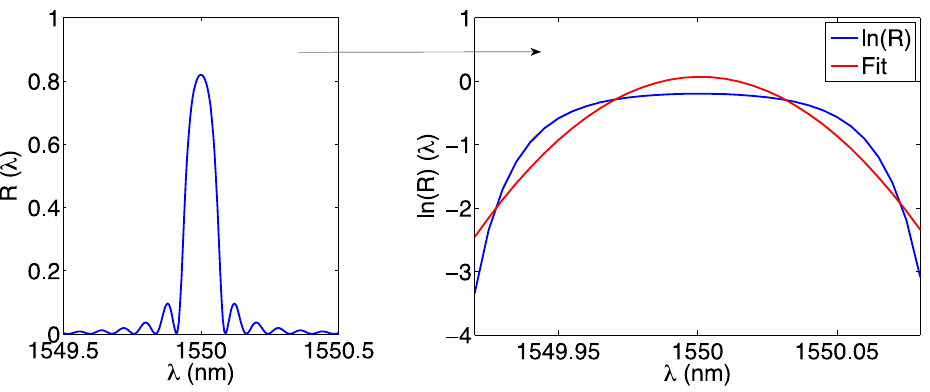
Figure 7. Sketch of the second-order polynomial fit peak tracking; interpolated spectrum is shown in red.